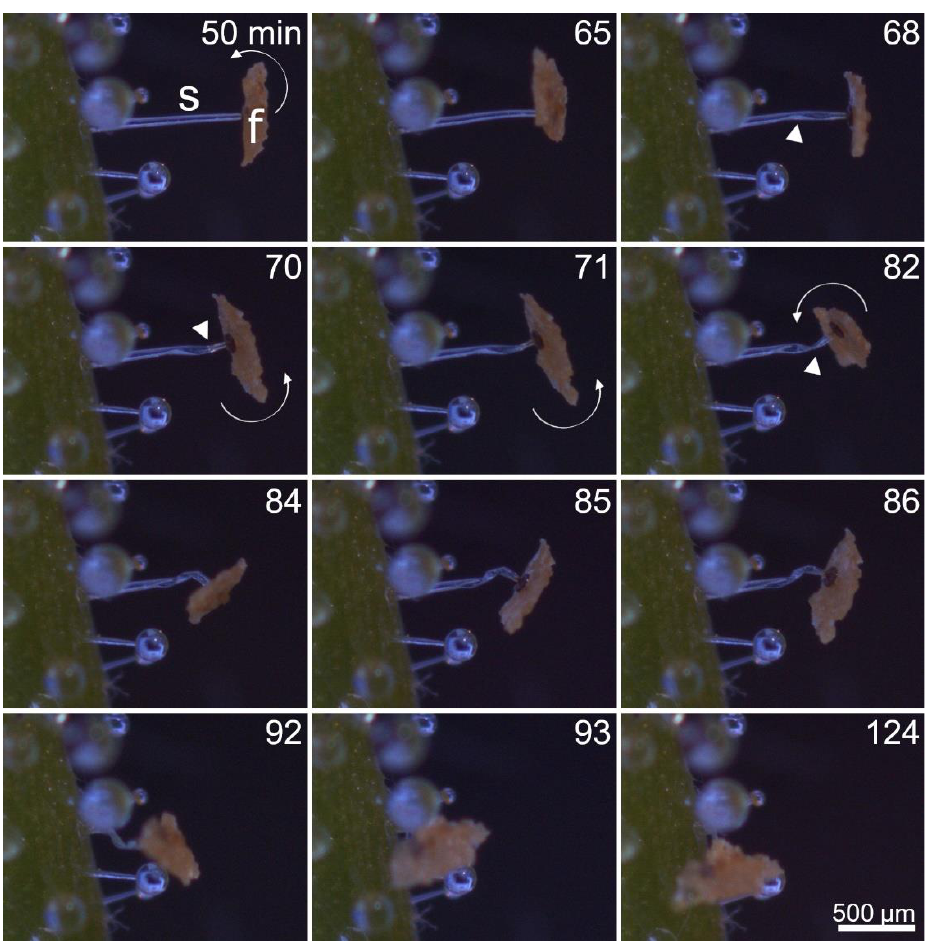
Figure 5. Kinematics of a stalked gland stimulated with a fish food flake (f). 50 min after stimulation, the stalked gland begins to move. Initially, the stalk cell (s) twists, which causes the head to rotate counterclockwise (indicated with fine white arrows). The stalk cell kinks numerous times (indicated by thick white arrows) and finally collapses. Times [min] are indicated. The images are frames from Movie S3.